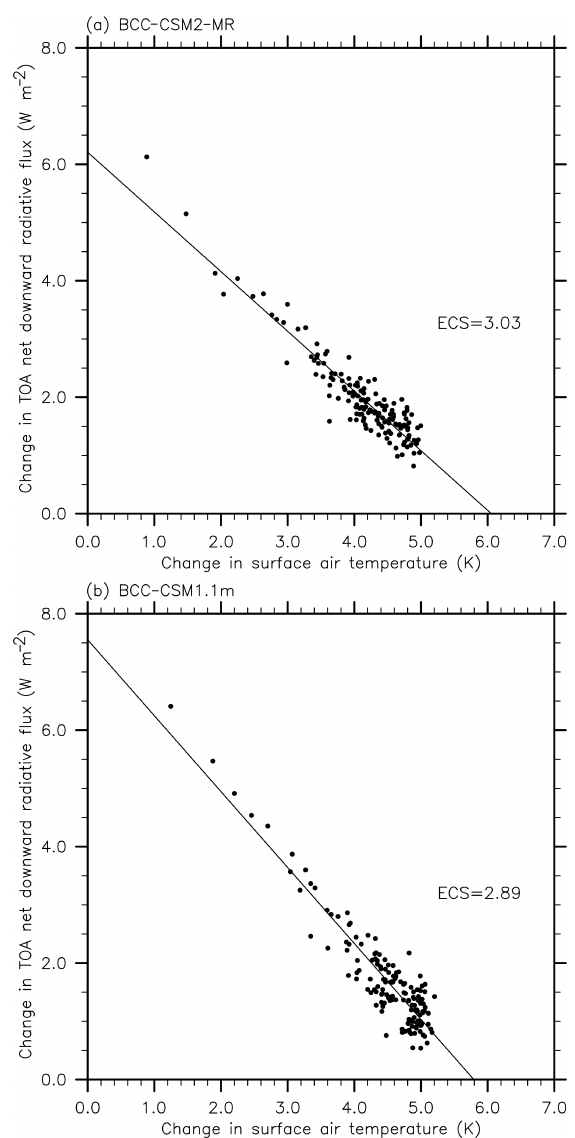
Figure 6. Relationships between the change in the net top-of- atmosphere radiative flux and the global-mean surface air temper- ature change simulated with an abrupt 4 × CO 2 increase relative to the preindustrial control